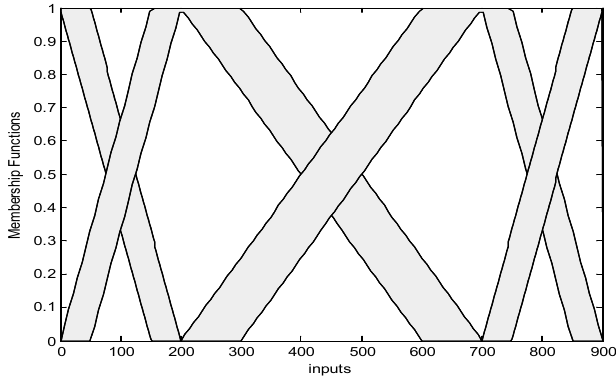
Figure 12. Antecedent membership functions of the inputs. Table 4. The rule base and consequents of the proposed IT2-FMIC.